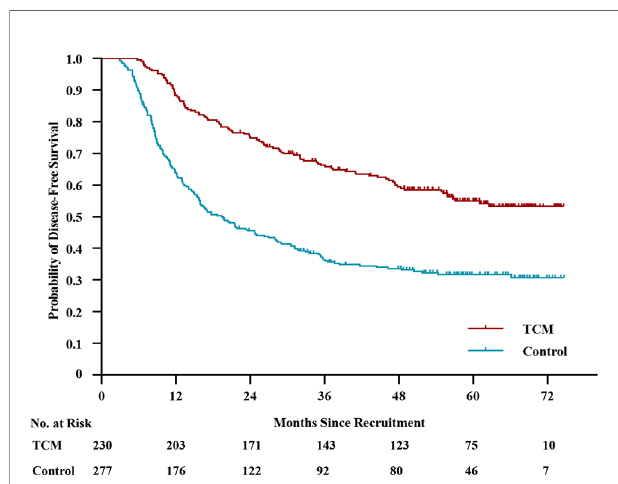
FIGURE 1 | Kaplan – Meier Estimates of Disease-free